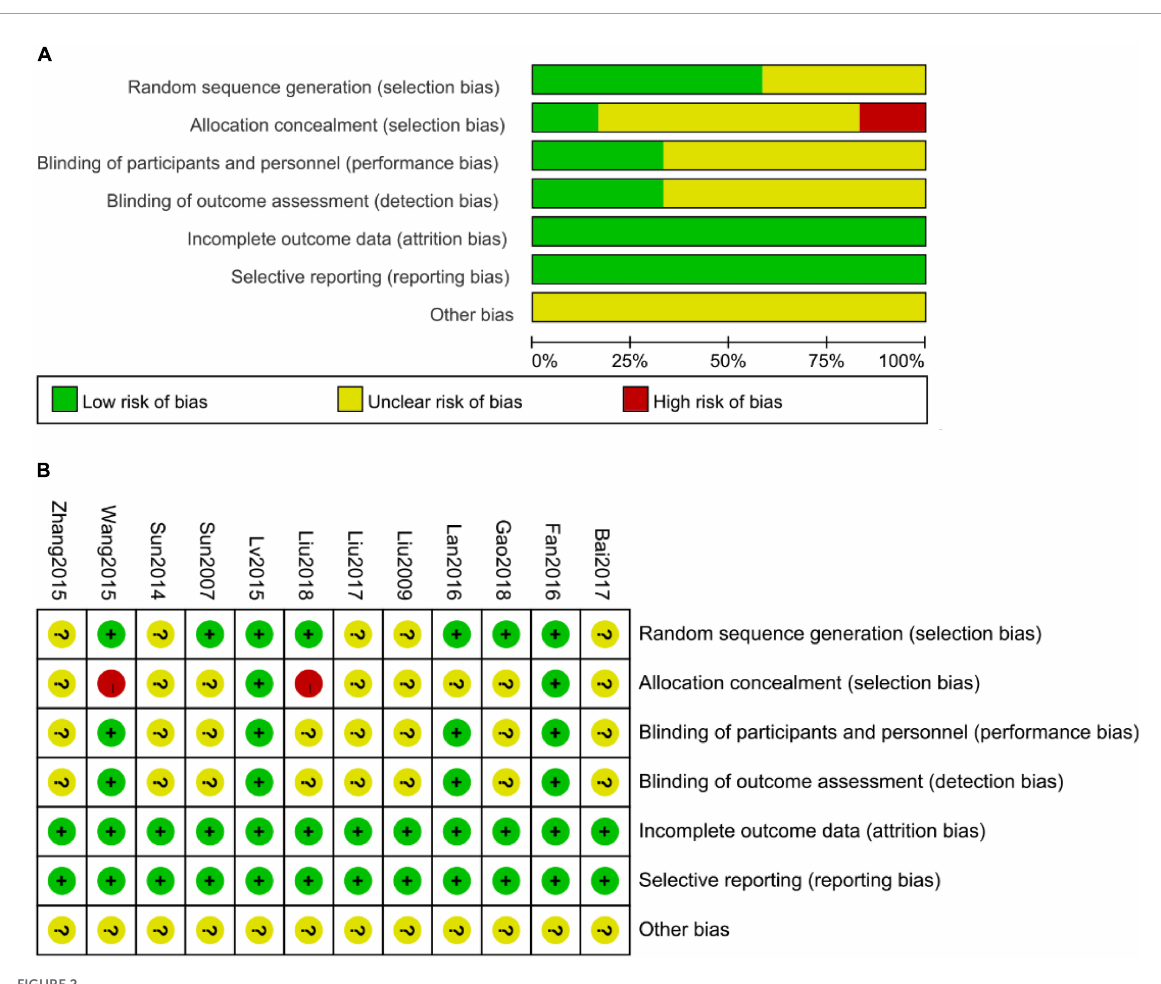
as subcutaneous bleeding, acupuncture pain, and insomnia.